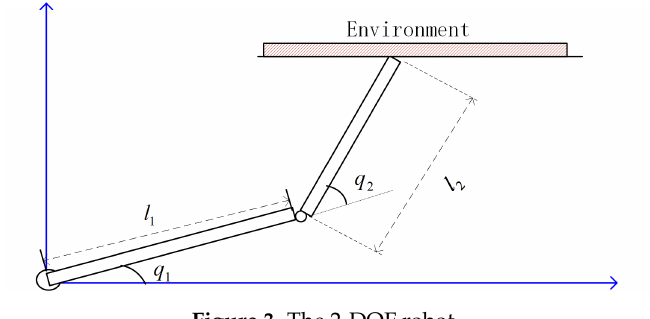
Figure 3. The 2-DOF